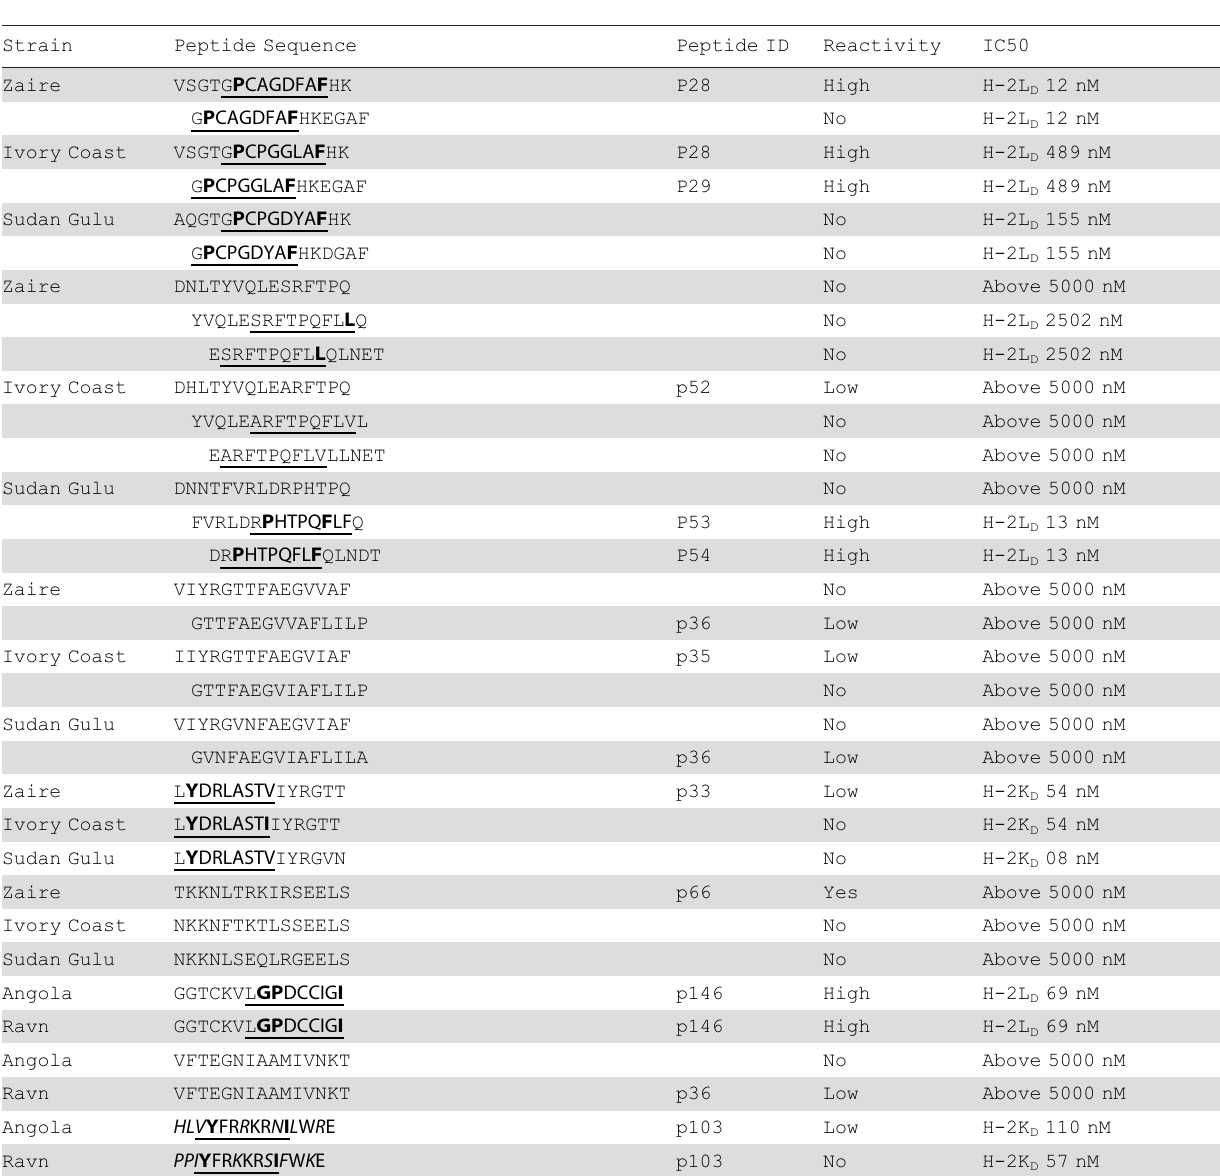
Table 1. Cross reactivity of identified murine T cell